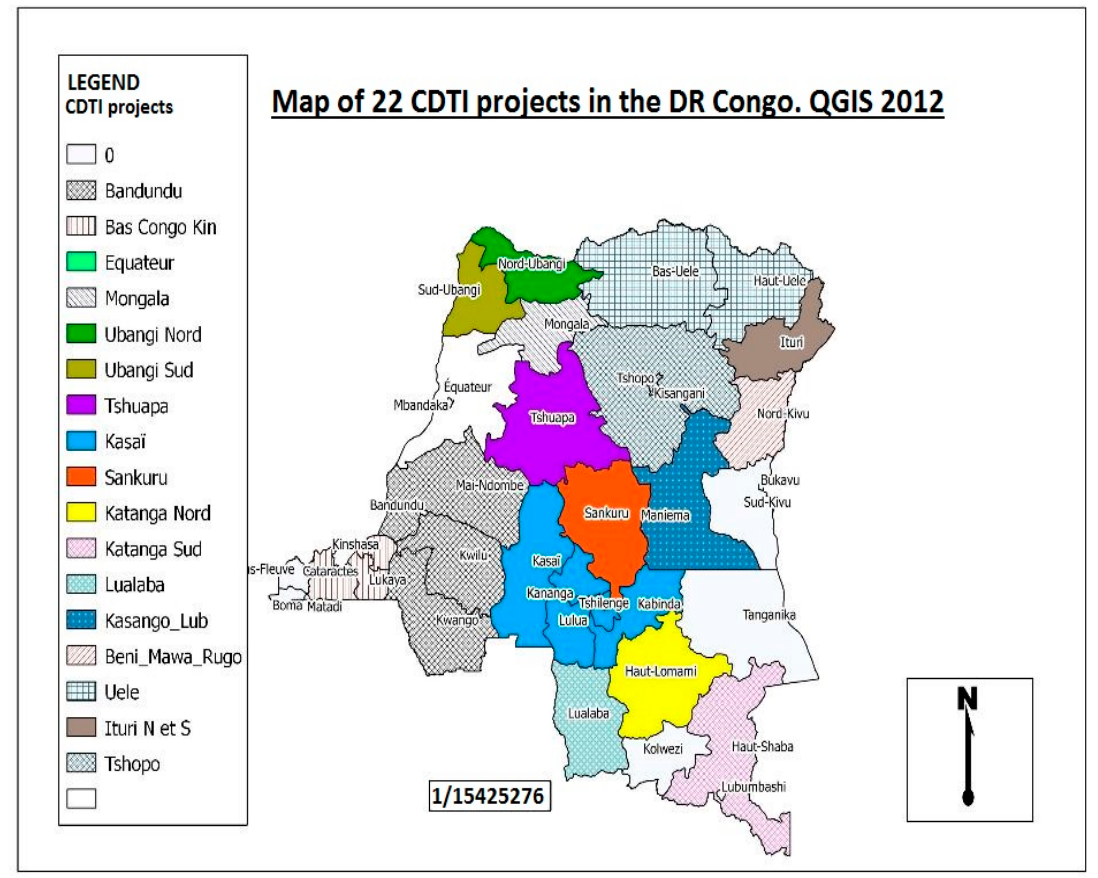
Figure 4. Rapid epidemiological mapping of onchocerciasis in the Democratic Republic of Congo, showing all 22 CDTI projects 2012 [13]. The map shows that onchocerciasis is present in all provinces of the country. Other CDTI projects not mentioned in the legend but visible on the map are: Ituri health zone which have 2 projects, Lubutu, Masisi Walikale, Mongala and Rutshuru Goma.